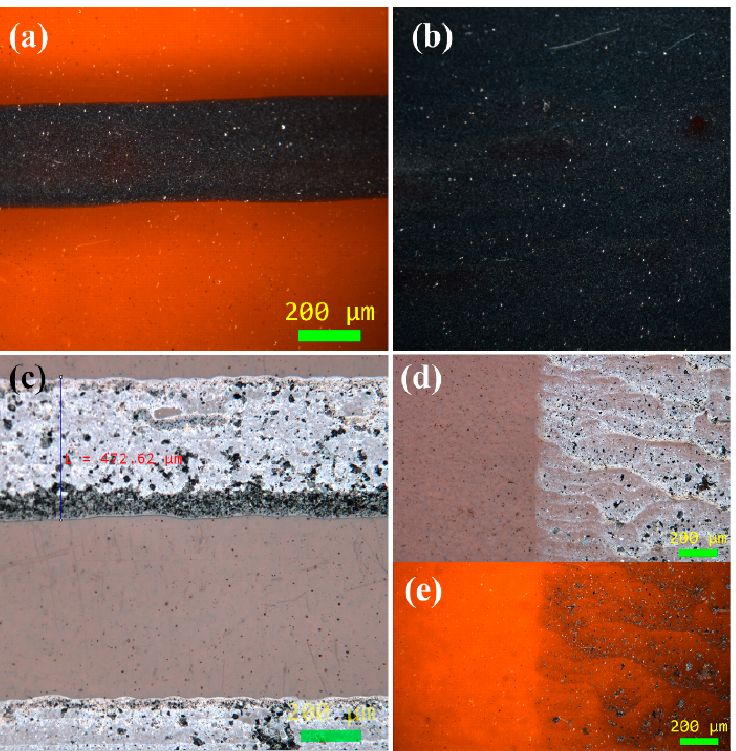
Figure 4. Printed graphene line ( a ) and area ( b ); printed f ‐ rGO line ( c ) and area ( d ), dark filter; ( e ), bright filter.